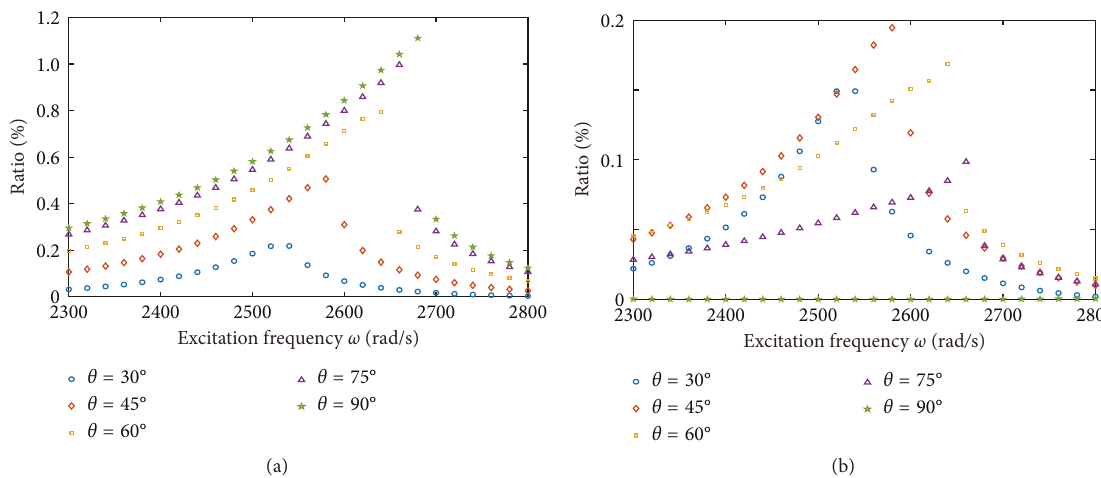
Figure 9: The energy ratio at different contact angles. (a) Energy storage by the contact force. (b) Energy consumption by the friction force.